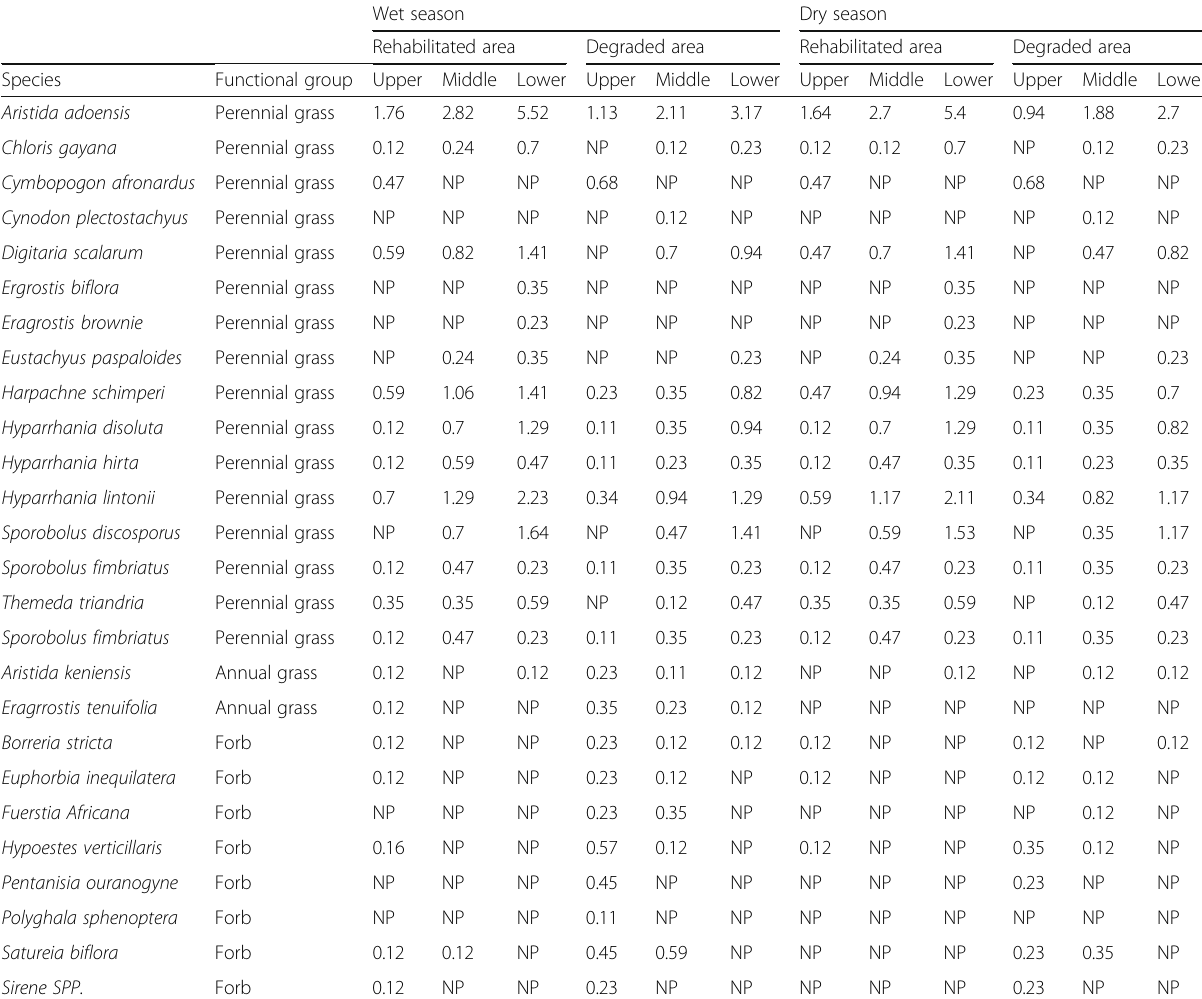
Table 3 Percent herbaceous composition in rehabilitated and degraded areas of Suswa catchment during wet and dry